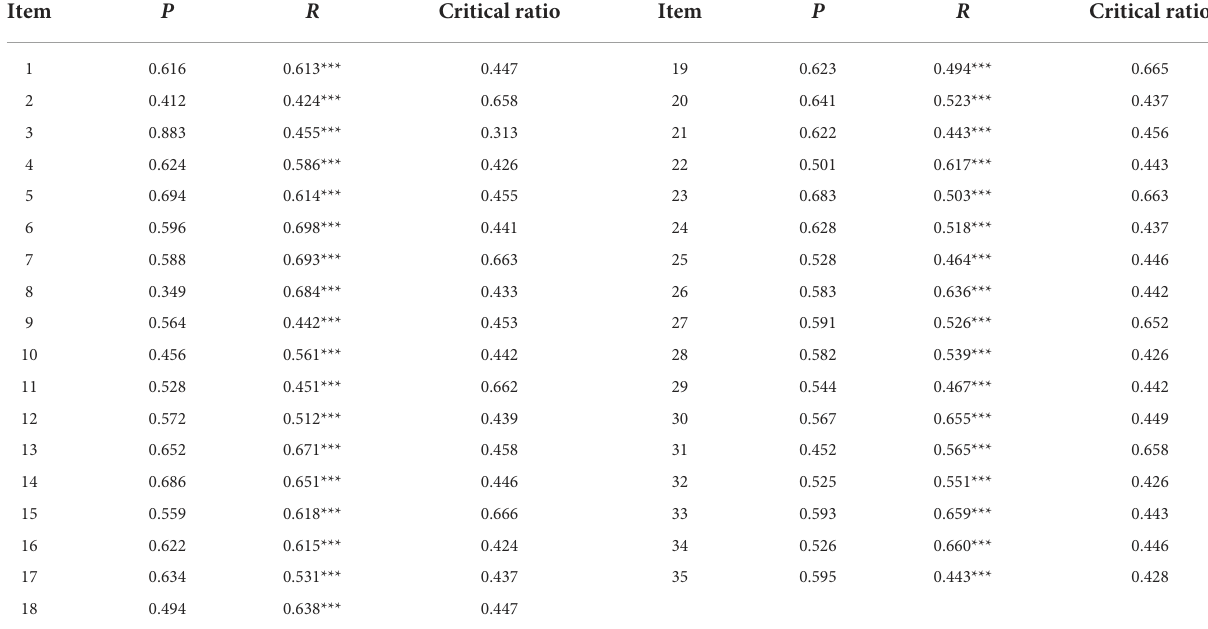
TABLE 2 Results of item analysis.